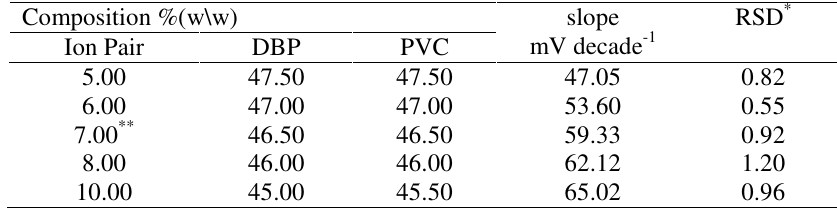
Table 1. Composition of different RTH-TPB membranes and slopes of the corresponding calibration graphs at 25 °C.